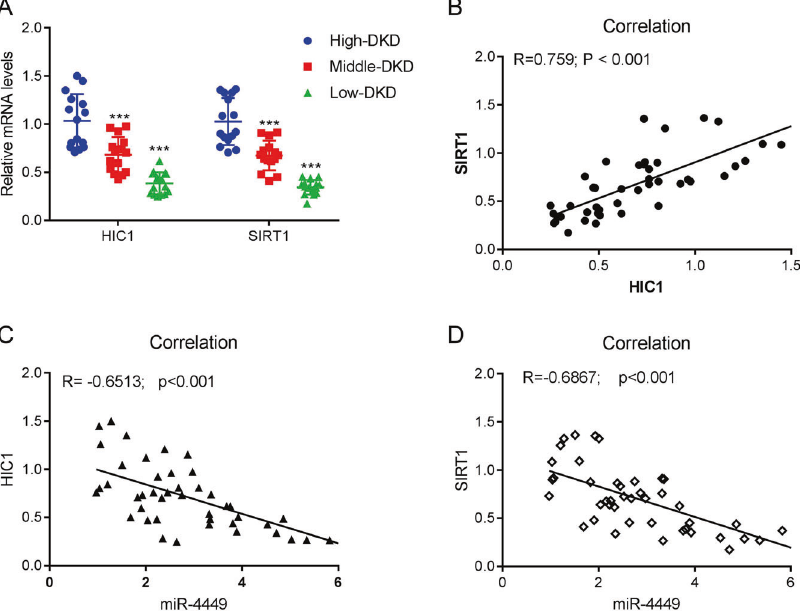
Fig. 10 miR-4449 expression was negatively correlated with the transcriptomic levels of HIC1 in patients with DKD. RNA from kidney tissues of patients with DKD was isolated. A The relative mRNA level of HIC1 in patients with DKD at different stages was measured with qRT- PCR. B The correlation between the expression of HIC1 and miR-4449 was plotted. *** P < 0.001 vs.